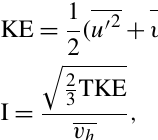
Figure 5. Crosswise forces (perpendicular to streamlines) at hub height along x , averaged along y for the small wind farm (a) and large wind farm (b) . Shown are the divergence of the vertical turbu- lent momentum flux (resolved + SGS) F , the geostrophic forcing G (difference between geostrophic pressure gradient force and Corio- lis force) and the perturbation pressure gradient force P